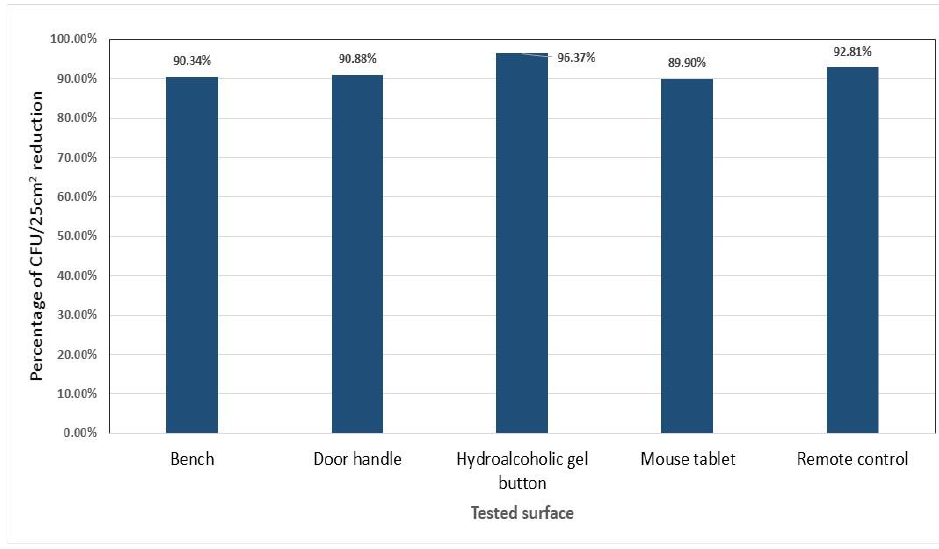
Figure 2. Average percentages of CFU/25 cm 2 reduction in an ISO 8 room per high-touch surface tested covered with treated polyethylene adhesive film compared with noncovered surfaces.